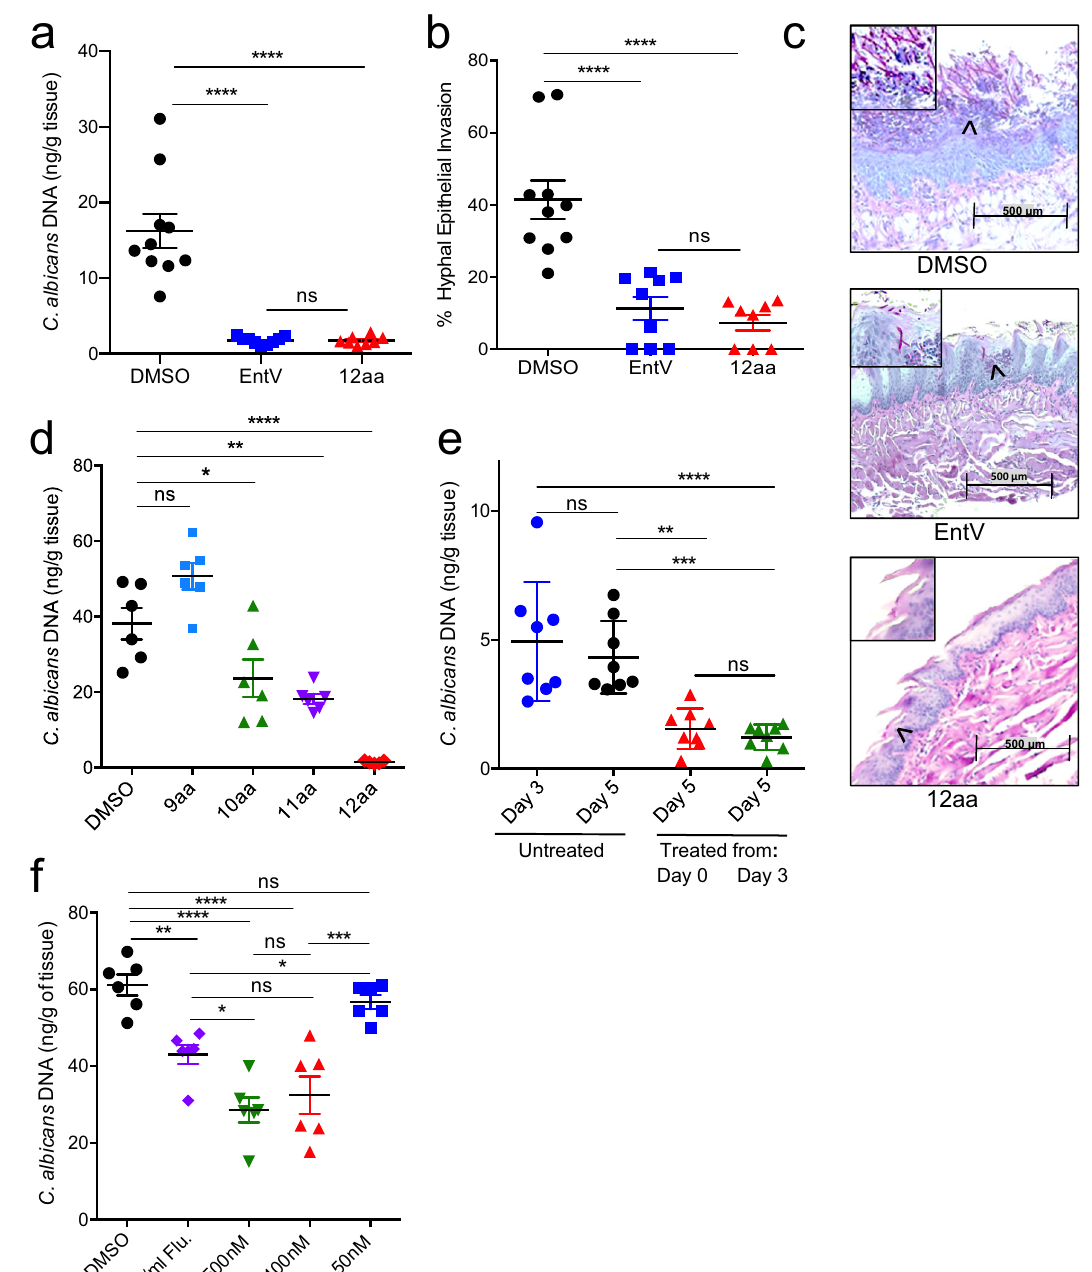
Fig.5|The12merisprotectiveinamousemodeloforopharyngealcandidiasis. Amount of C. albicans DNA detected by qPCR, a , and percentage of the tongue surface showing hyphal invasion, b , in untreated animals compared to those given 100nM EntV and 12aa α 7 in their drinking water for 5 days following inoculation. c Representative pictures used to score hyphal invasion. Pink staining cells in the areas that are magni fi ed, indicated by the black arrow heads, are C. albicans . The cells in the control sample show an elongated, hyphal morphotype more pre- valently invading the tissue compared to the treated samples. d The amount of C. albicans DNA detected by qPCR in animals treated with 100nM of different frag- mentlengths of the α 7peptideatday5. e The amountof C.albicans DNAdetected by qPCR in animals at day 3 or 5 following treatment with 100nM of the 12mer